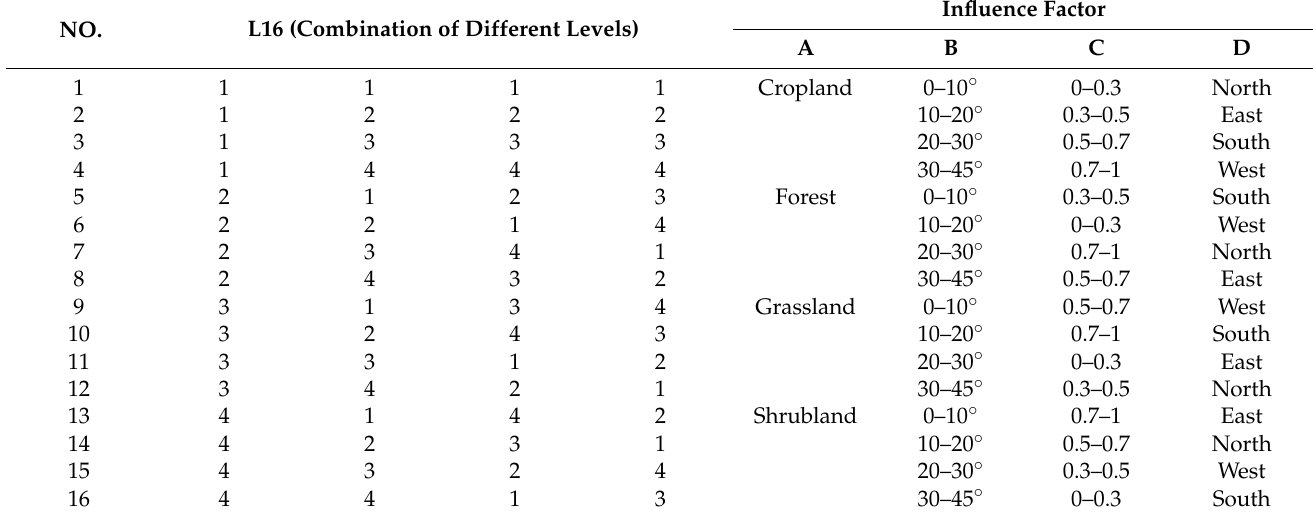
Table 4. Taguchi experimental conditions were used in this study.